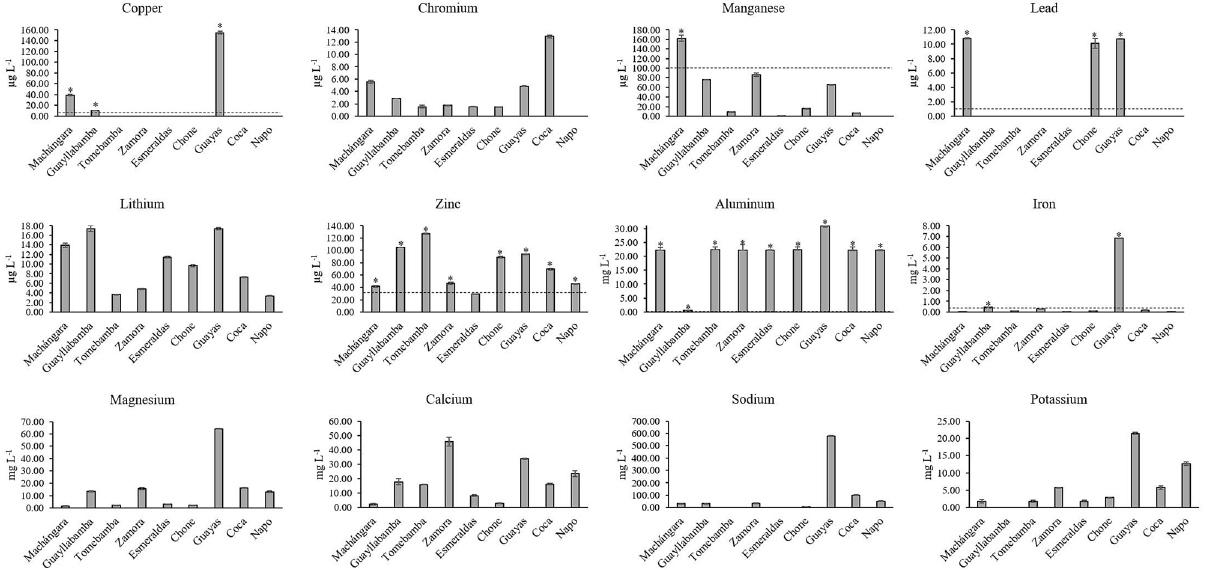
Figure 4. Average and standard deviation values of trace metals and major elements quantified in water samples of the nine rivers in this study. Legend: Threshold of a certain trace metal or major element (-—-); * exceedance values according to